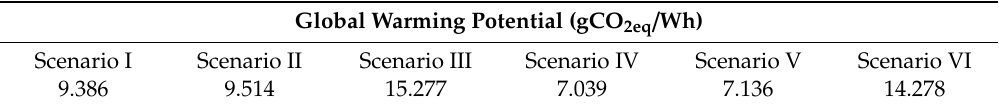
Table 7. GWP results for TE cooling system, gCO 2eq / Wh.